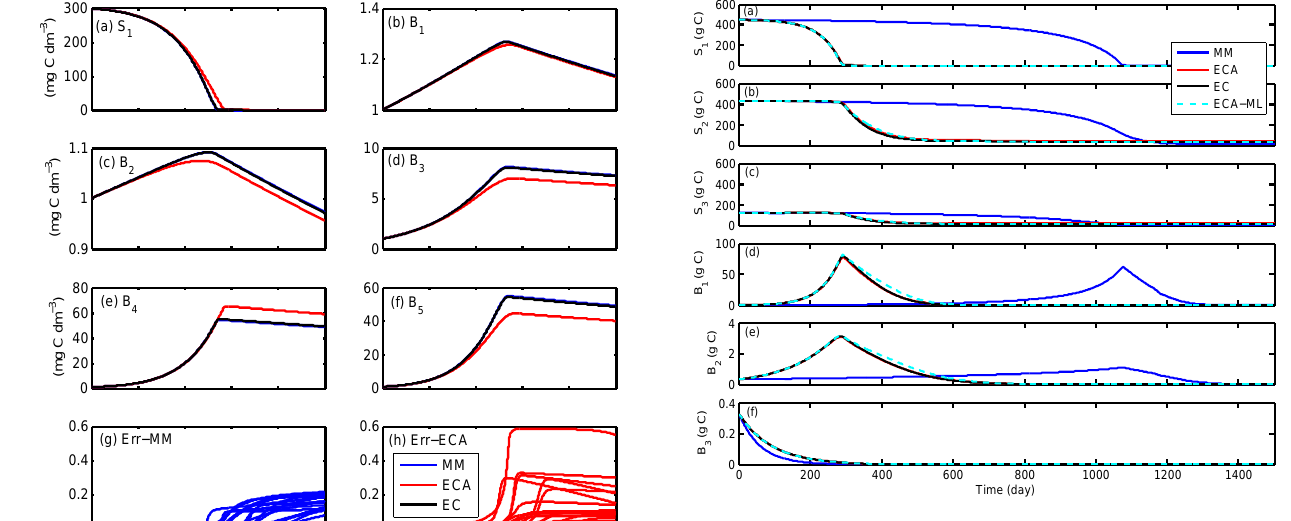
Fig. 9. Time series of relevant state variables simulated from the application of different substrate kinetics to microbial model S3B3.